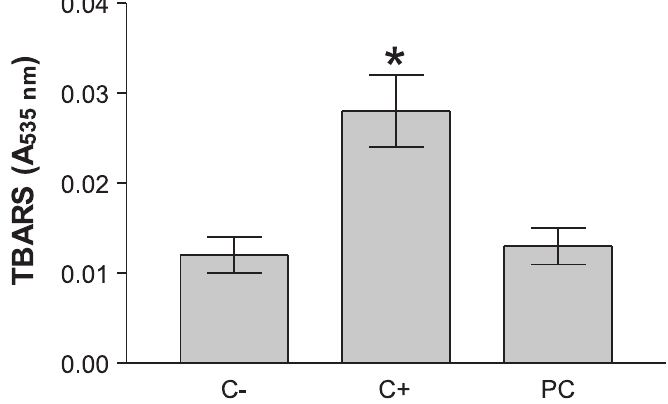
FIGURE 2 – Peroxidation of biomolecules that are present in liver nuclear fractions. Nuclear fractions were incubated in the absence (C-) or in the presence of 1 mM catechol (PC) for 17 hours at room temperature. Positive controls (C+) were incubated in the presence of 5 mM FeSO and 500 mM ascorbate at the same conditions. Afterward, peroxidation was assessed by measuring the formation 4 TBARS which absorbs light at 535 nm. Data are expressed as mean ± SD. *, P < 0.05 compared to